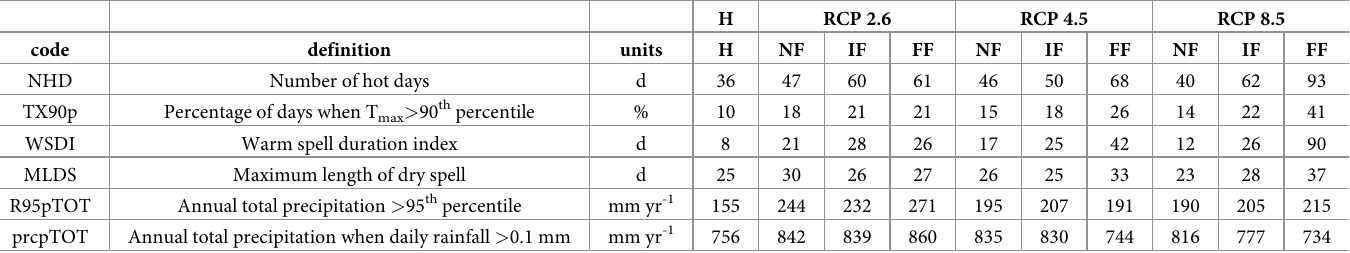
Table 2. Values of the 6 selected ETCCDI climate change indices used in this study for the Lusignan area. The six indices are based on daily temperature and precipi- tation under the three different RCP scenarios and for the historical (H), near future (NF), intermediate future (IF) and far future (FF)